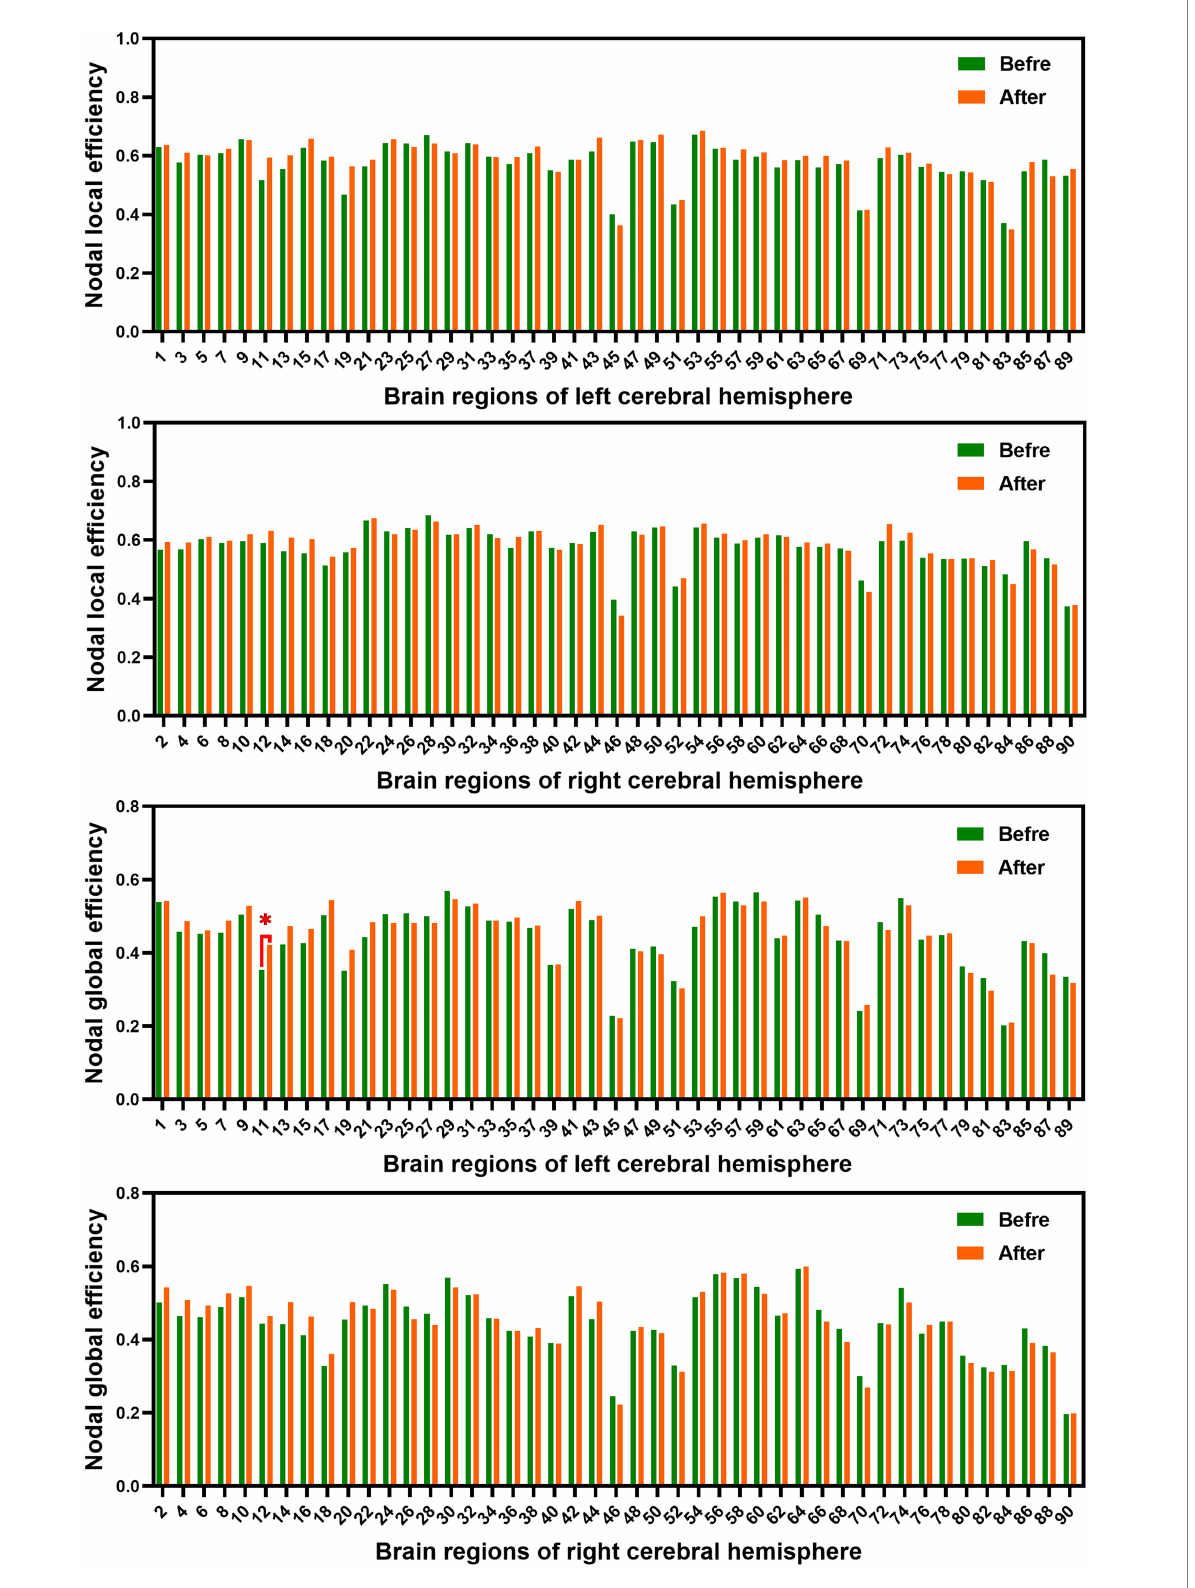
FIGURE 4 Comparison of AUC of nodal efficiency of male rowing athletes before and after tDCS. AUC, area under the curve; tDCS, transcranial direct current stimulation. Values of p were obtained by paired t tests. p < 0.05 indicated statistically significant